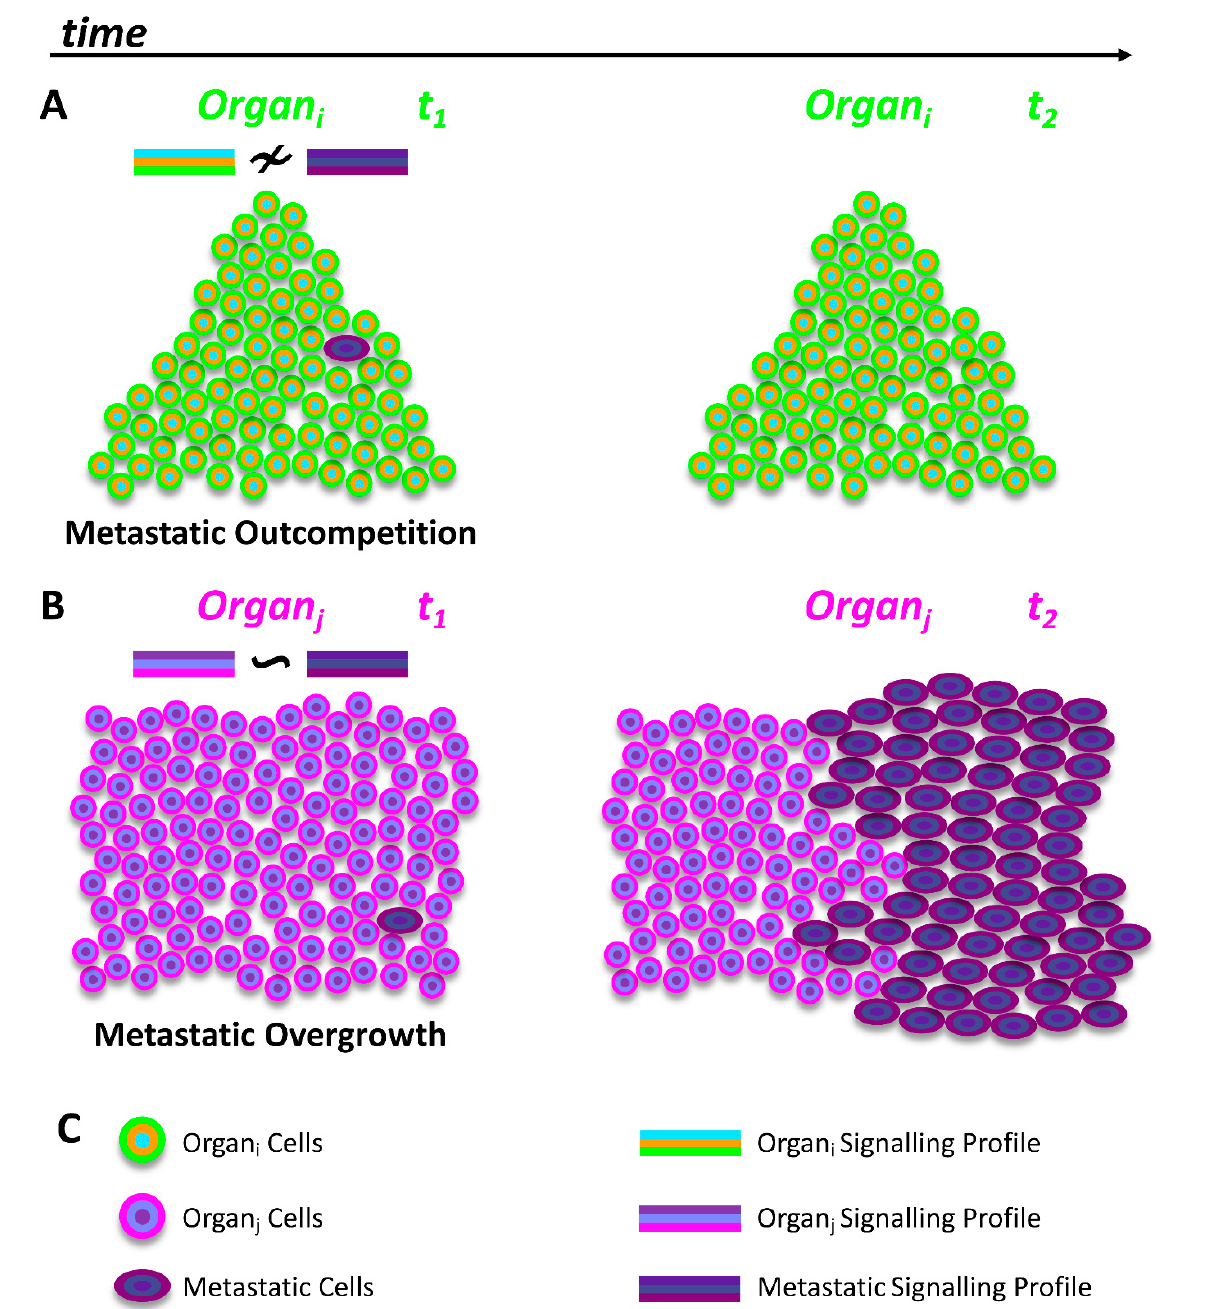
Figure 2. Metastatic Competition hypothesis and tumoral growth. ( A ). Metastatic cells with different signalling profiles ( (cid:28) ) than the signalling profiles from the target organs (organ i ) might be outcompeted and eliminated from the tumoral field, thus abolishing metastatic growths. ( B ). Metastatic cells with similar signalling profiles (~) to the signalling profiles from the target organs (organ j ) might not be eliminated from the organ microenvironment, allowing them to proliferate and form metastatic overgrowths. ( C ). Signalling profiles and cells from organ i and organ j are depicted in different colours; t refers to